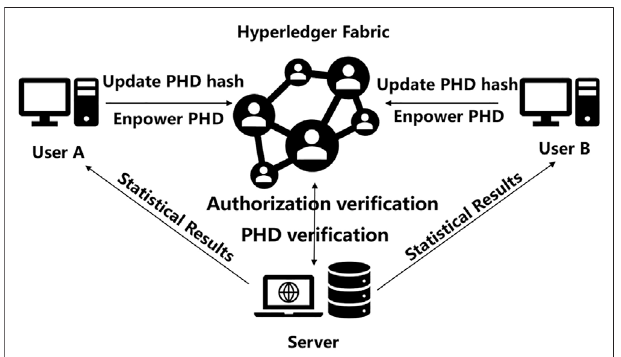
FIGURE 2 | Physical implementation of the PHDMF. The framework consisted of the central servers, local node servers, and underlying